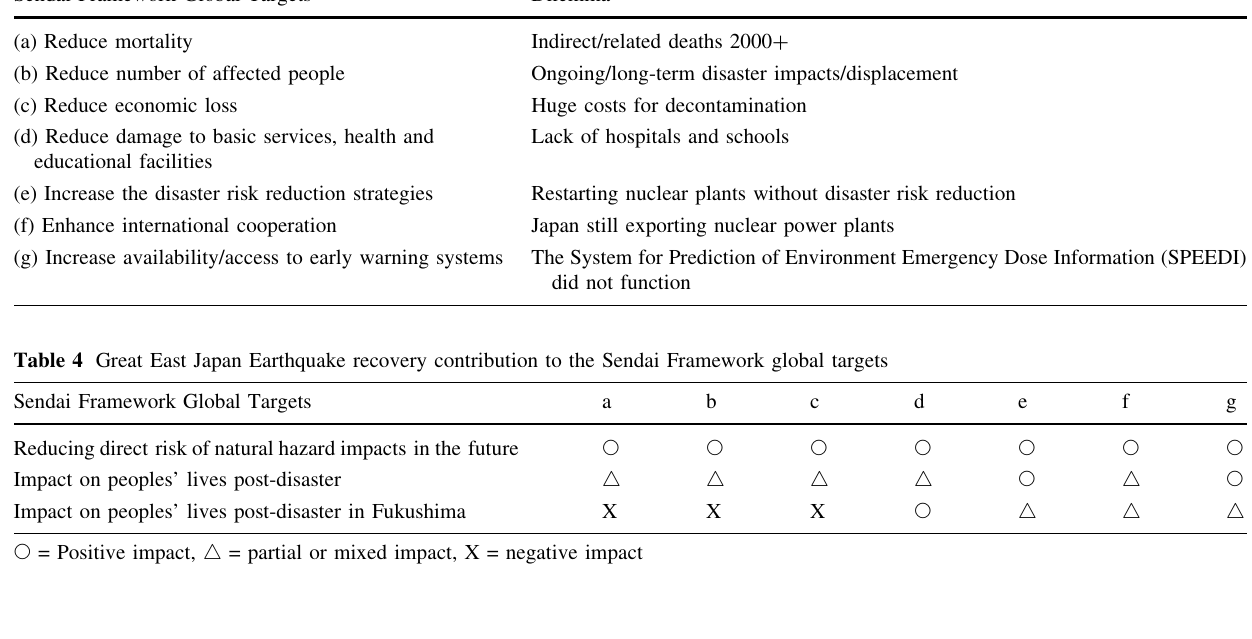
Table 3 ‘‘Dilemmas’’ in Fukushima—contradictions between the Sendai Framework’s global targets and the reality (Fukushima Booklet Committee 2018) Sendai Framework Global Targets